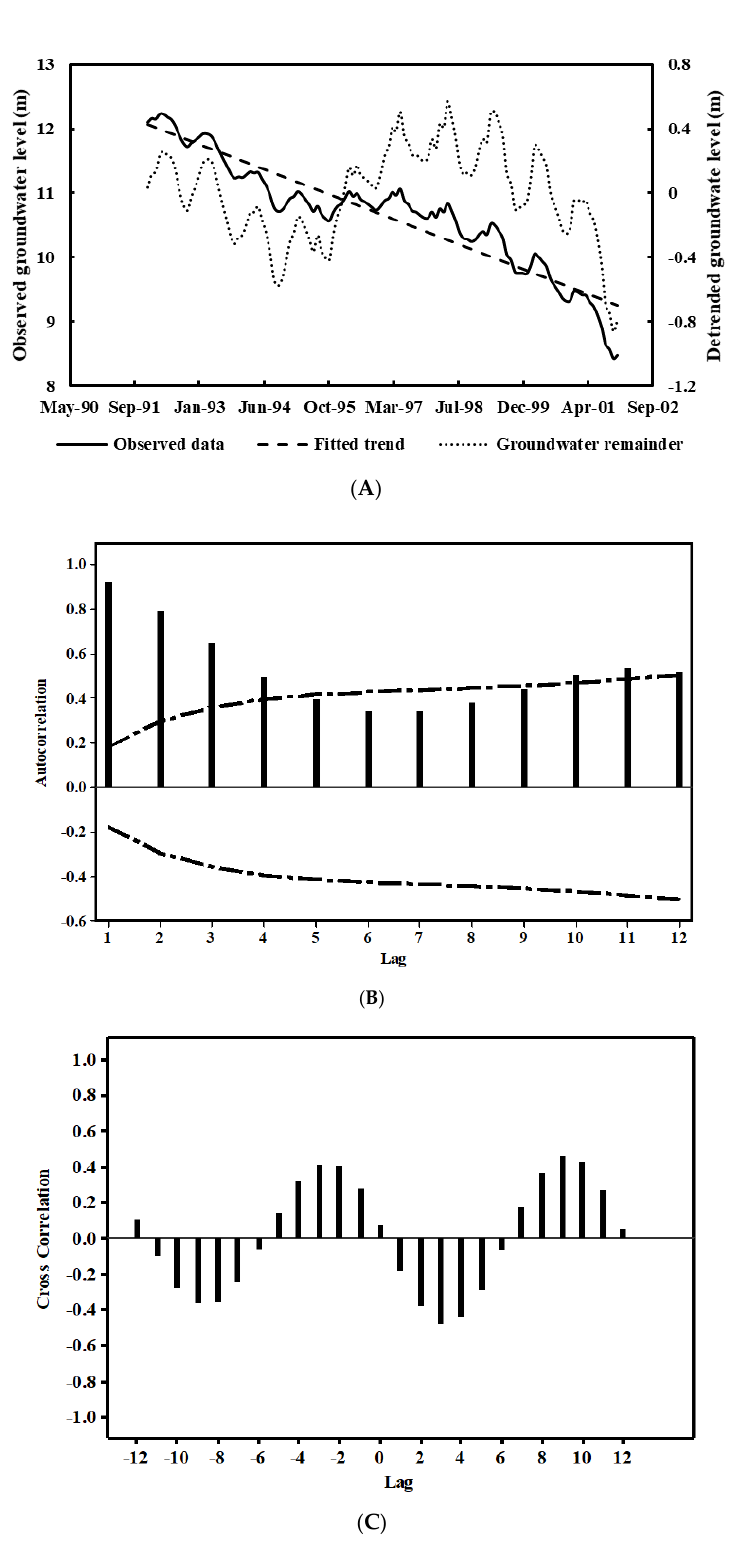
Figure 5. ( A ) Groundwater levels detrending procedure for well BN-1A. ( B ) Autocorrelation function (correlogram) applied for groundwater levels remainder at well BN-1A. Upper and lower dashed lines designate significant correlation limits. ( C ) Cross correlation between groundwater depth remainder and monthly average temperature at well BN-1A.